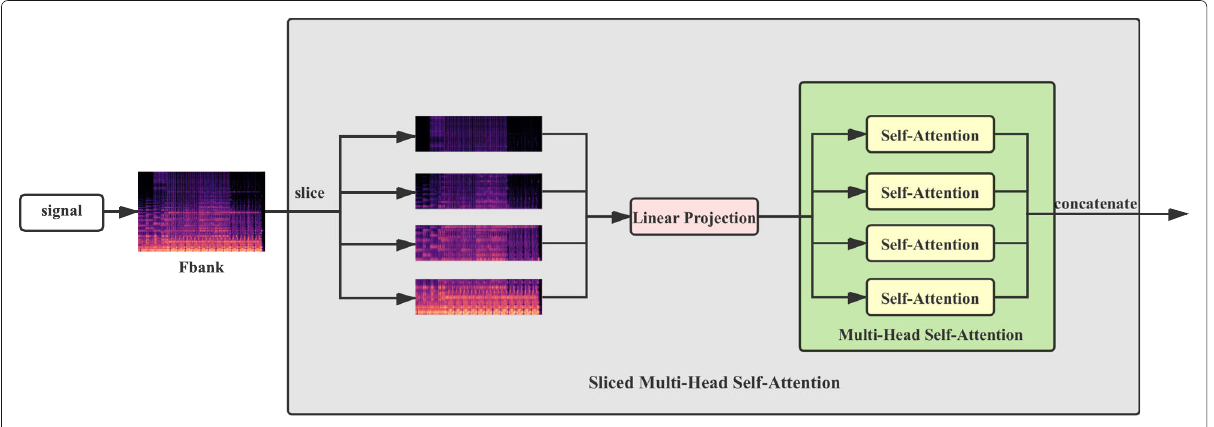
Fig. 5 The architecture of our SAMA model